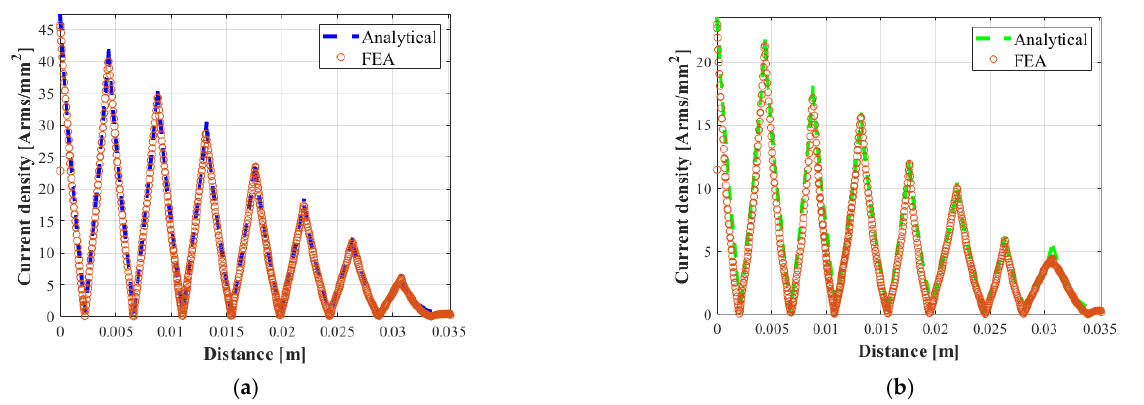
Figure 6. Comparison of analytical and FE results in terms of current density. ( a ) Phase arrangement: AAAAAAAA at 40 Apk, 2 kHz, ( b ) Phase arrangement: ABABABAB at 40 Apk, 2 kHz.